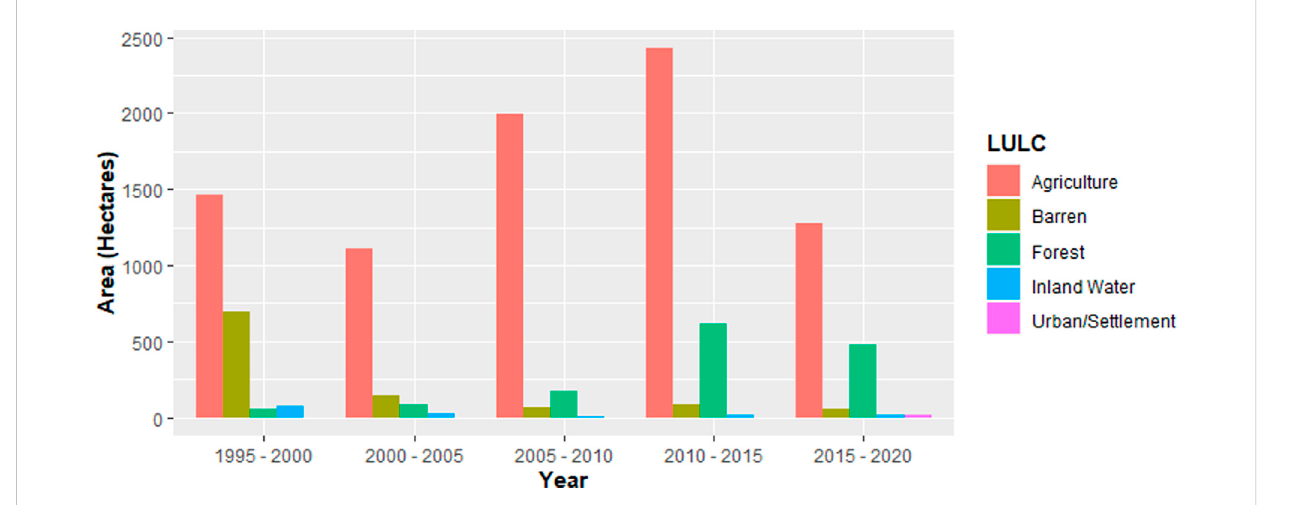
FIGURE 4 Historical land/LULC loss from 1995 to